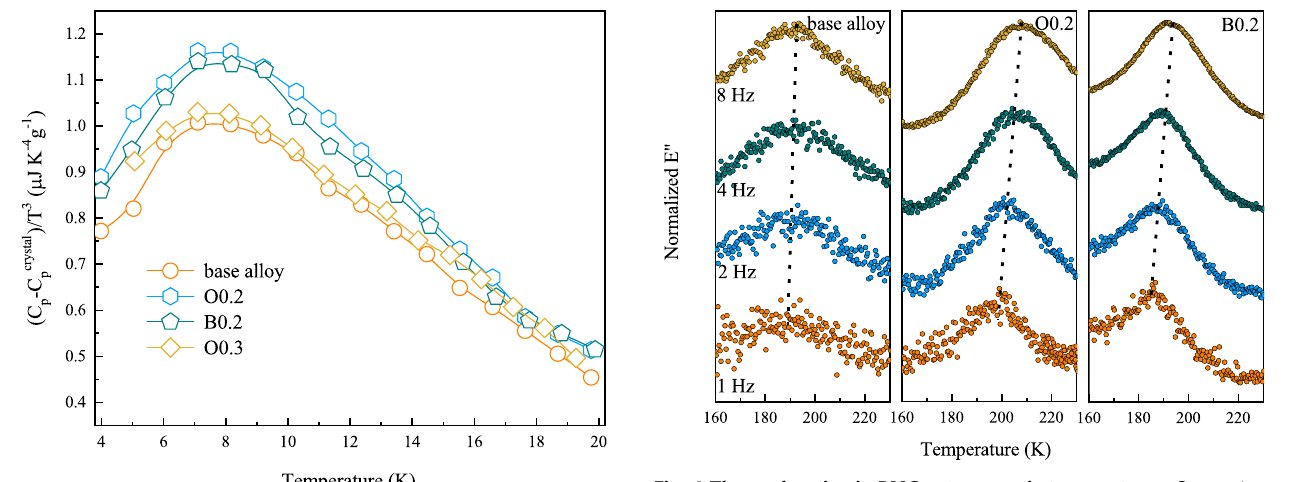
Fig. 4 The γ relaxation in BMGs at cryogenic temperatures. Comparison of isochronal relaxation spectrum for the base alloy, and for the doped alloys O0.2 and B0.2 within the range of 160 – 230 K at discrete frequencies of 1 Hz, 2 Hz, 4 Hz, and 8 Hz. A more pronounced γ relaxation with lower crystal ) p activation energy was observed in the alloys O0.2 and